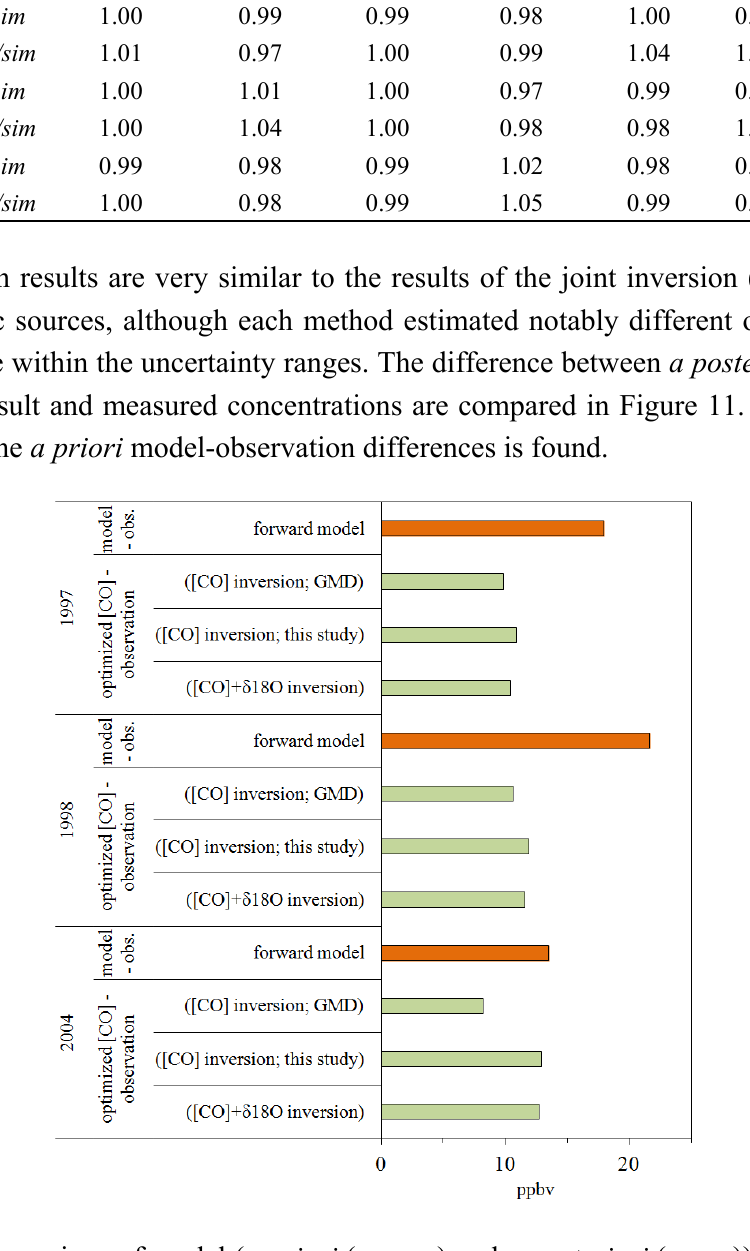
Figure 11. Comparison of model ( a priori (orange) and a posteriori (green))—observation difference of the Northern